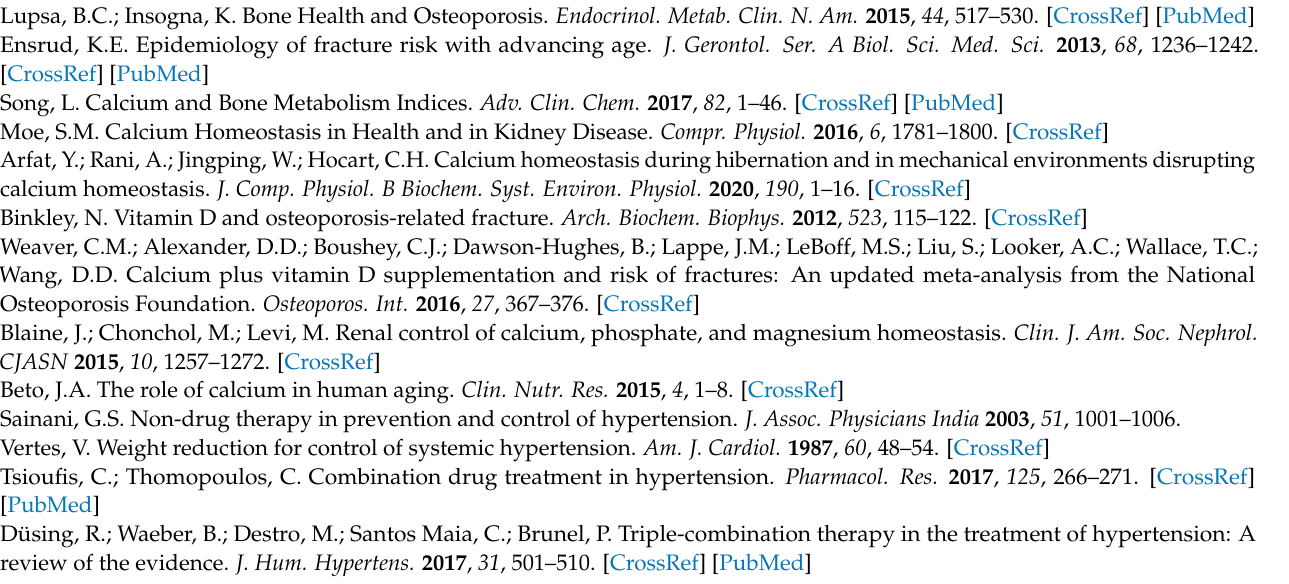
groups. Table S2: Incidence density of fracture. Table S3: Multiple Cox proportional hazard regression results for